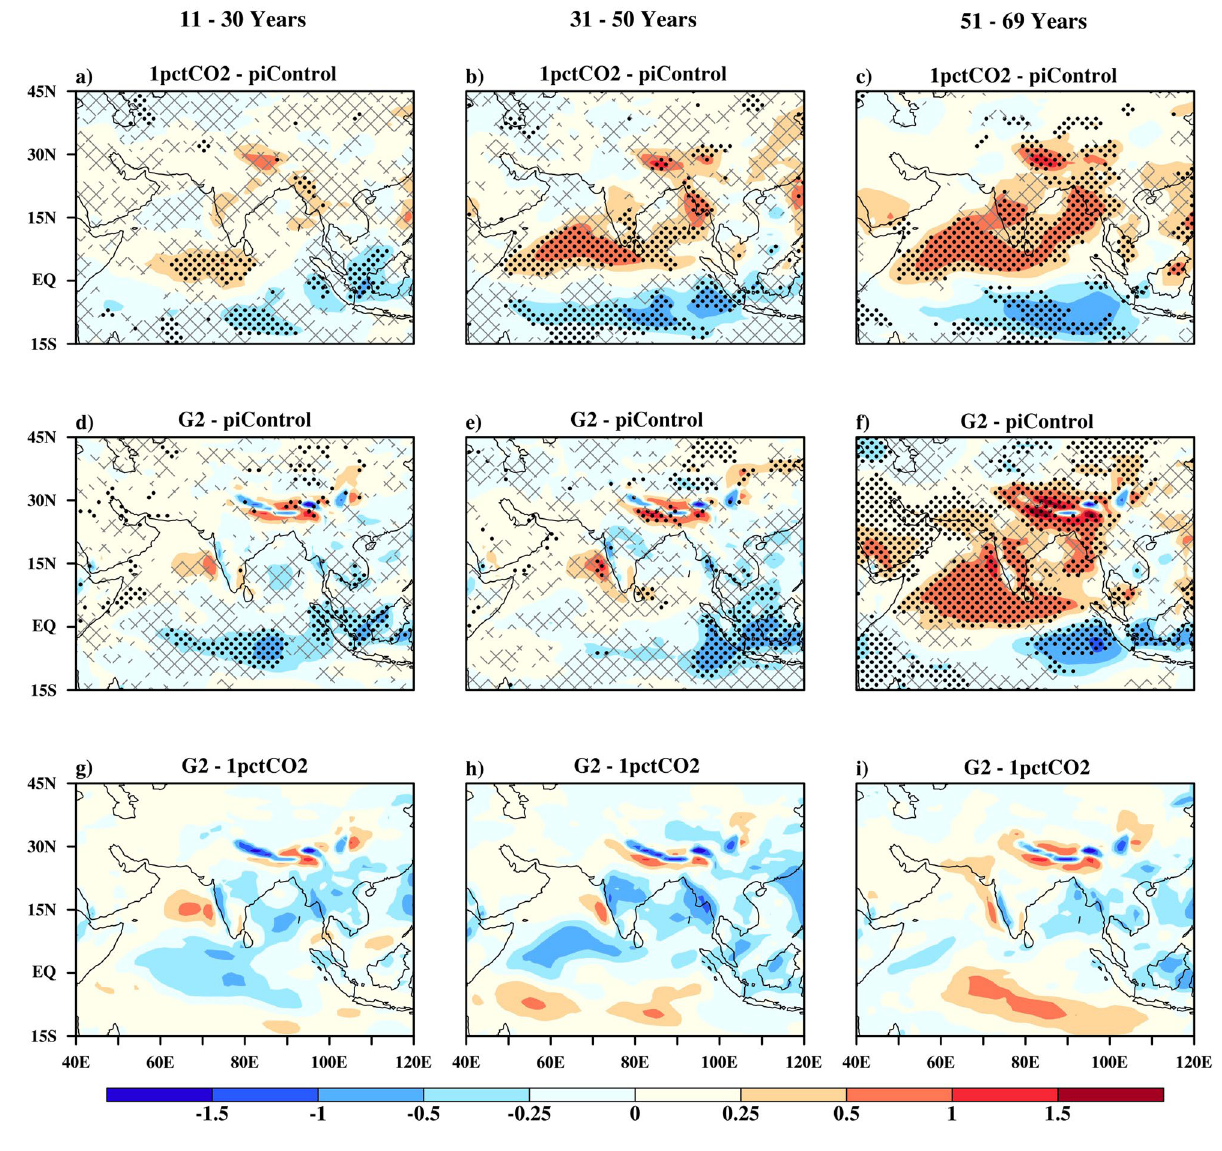
Figure 6. As in Fig. 2 but for precipitation we have observed that lateral displacement of local high and low Somali Jet speed affects the positioning of moisture convergence. Precipitation changes. JJAS mean precipitation changes for 1pctCO2 and G2 w.r.t piControl are shown in Fig. 6. The stippling and hatch criterion is the same as for surface air temperature. Over the 11–30 years period under the 1pctCO 2 scenario (Fig. 6a), a statistically significant increase in precipitation is projected for some parts of Myanmar and the equatorial Indian Ocean. Whereas, a marginal, insignificant increase in precipitation is projected over the majority of the Indian land however, at least 70% of the models agree in the sign of change that is positive. Over the subsequent 20 years period (years 31–50, Fig. 6b), a statistically significant increase in precipitation is projected over parts of the northeast Himalayan range and the mountains of Myanmar. The region near the equatorial Indian Ocean is projected to have an increase in precipitation, coincident with weak- ening of the TEJ. Over the south equatorial Indian Ocean and the maritime continent, precipitation is projected to decrease within this second 20 years period. For the 51–69 years period (Fig. 6c), precipitation is projected to increase over some parts of the Himalayan range, interiors of the southern peninsula, Myanmar, and parts of the Arabian Peninsula. The Bay of Bengal and north Indian Ocean are also projected to have significant increases in precipitation under the 1pctCO2 scenario. However, the regions to the south of equatorial Indian Ocean and the maritime continent are projected to have a significant decrease in precipitation in both 1pctCO2 and G2 scenarios. Under the G2 scenario, the majority of Indian land shows an insignificant decline in precipitation relative to piControl (Fig. 6d-e). However, precipitation is projected to increase over the east Arabian Sea. Exceptions